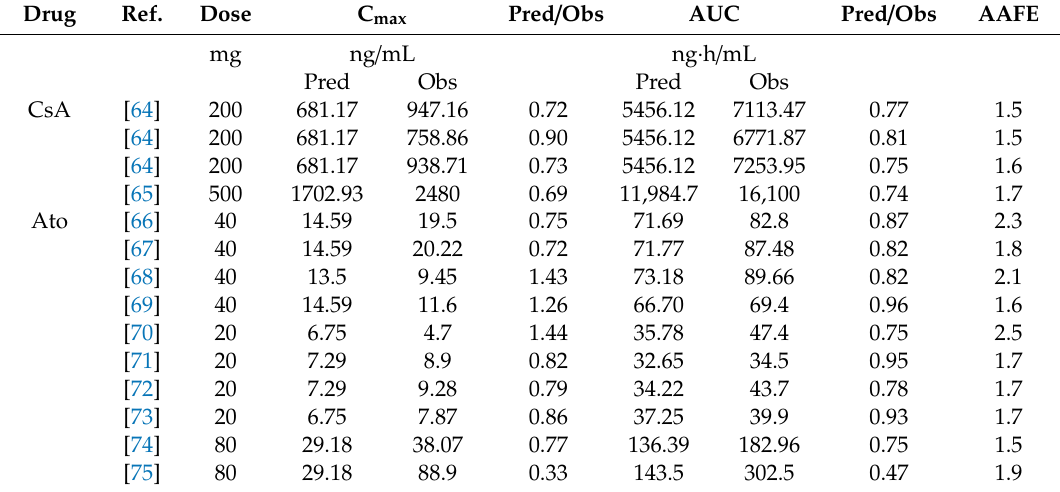
Figure 1. Predicted plasma concentrations (line) of the tested agents using the PBPK model and observed plasma concentrations (points) following a single dose to healthy subjects. Different points represented different dosages for drugs in the corresponding figure. ( A ) CsA; ( B ) atorvastatin; ( C ) cerivastatin; ( D ) pravastatin; ( E ) rosuvastatin; ( F ) fluvastatin; ( G ) simvastatin; ( H ) lovastatin; ( I ) repaglinide; ( J ) bosentan. Observed data were cited from reports [10,20,23,64 – 90]. Table 5. The predicted (Pred) pharmacokinetic parameters and the mean clinic observations (Obs) of cyclosporin A (CsA), atorvastatin (Ato), cerivastatin (Cer), pravastatin (Pra), rosuvastatin (Ros), fluvastatin (Flu), simvastatin (Sim), lovastatin (Lov), repaglinide (Rep) and bosentan (Bos). Drug